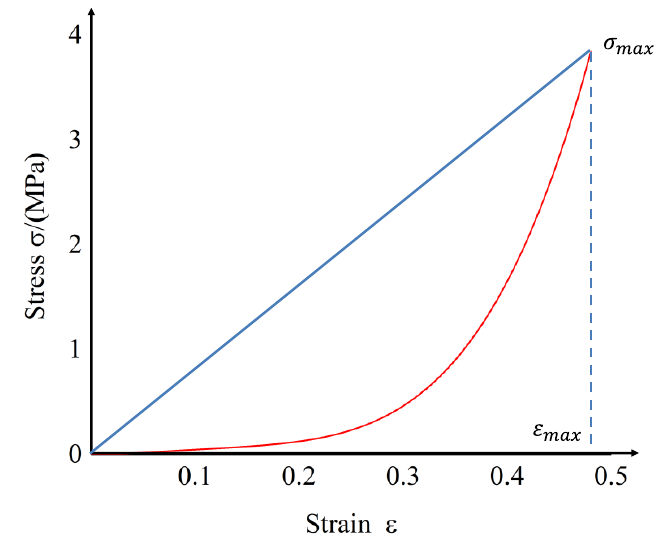
Figure 6. Secant of stress–strain